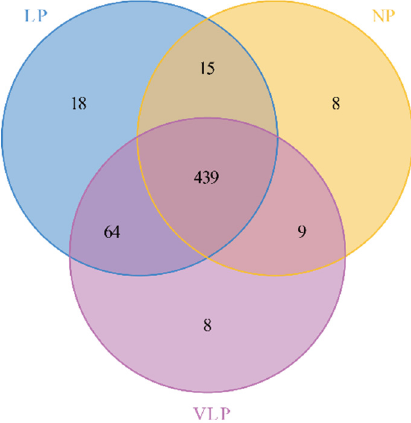
Figure 1. Venn diagram of shared operational taxonomic units (OTUs). The number of overlapping parts is the total number of OTUs among the groups, while the number of non-overlapping parts is the unique number of OTUs among the groups. NP = normal protein; LP = low-protein; VLP = very